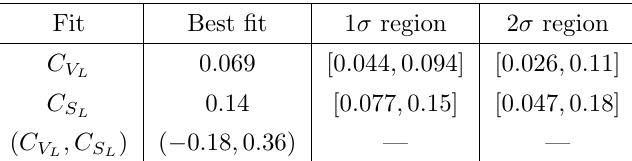
for the 2D (cid:12)t to Re C